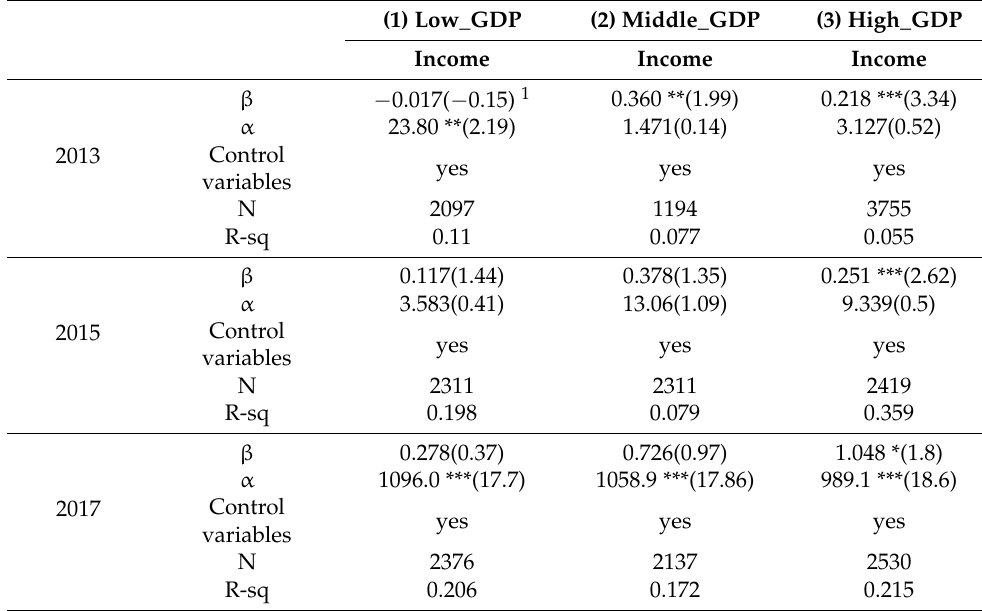
Table 9. Regional heterogeneity regression